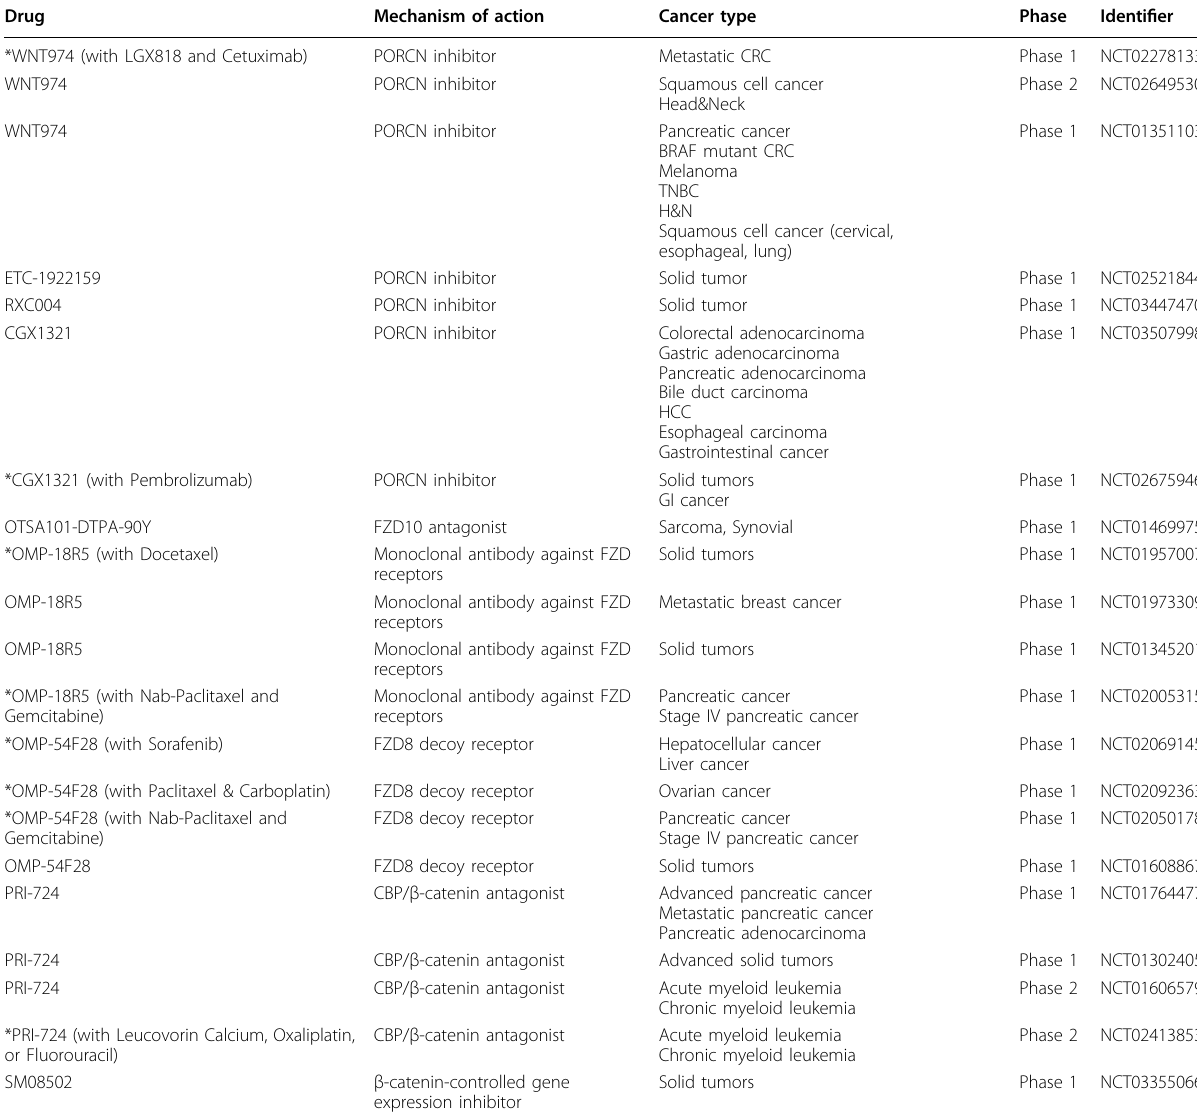
Table 1 Wnt/ β -catenin signaling inhibitors in current and past clinical trials.